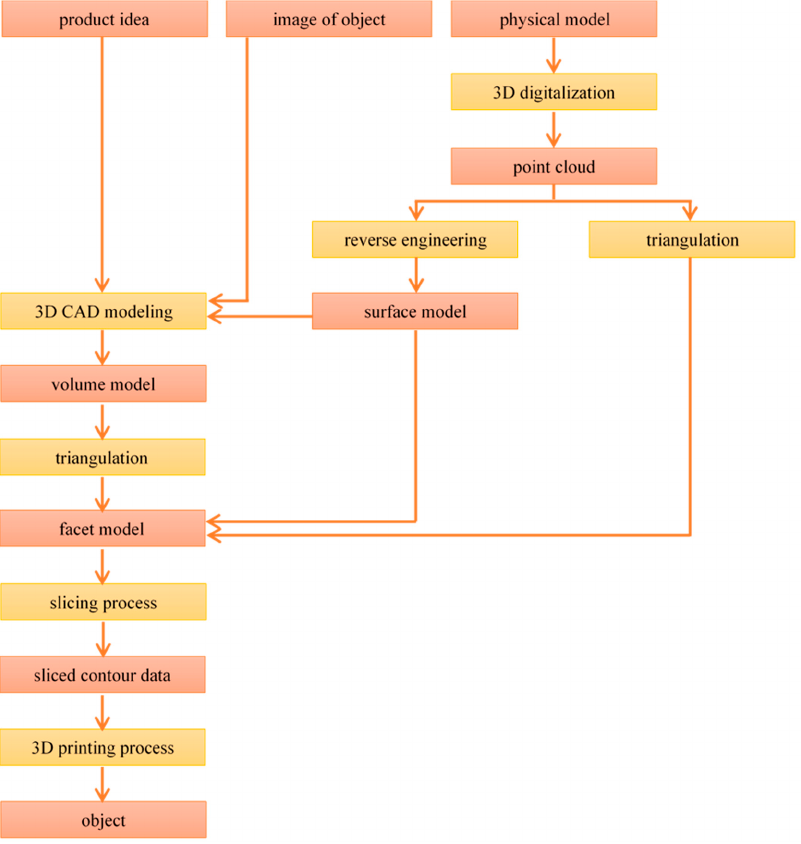
Figure 2. Stages of the additive manufacturing (AM) process.